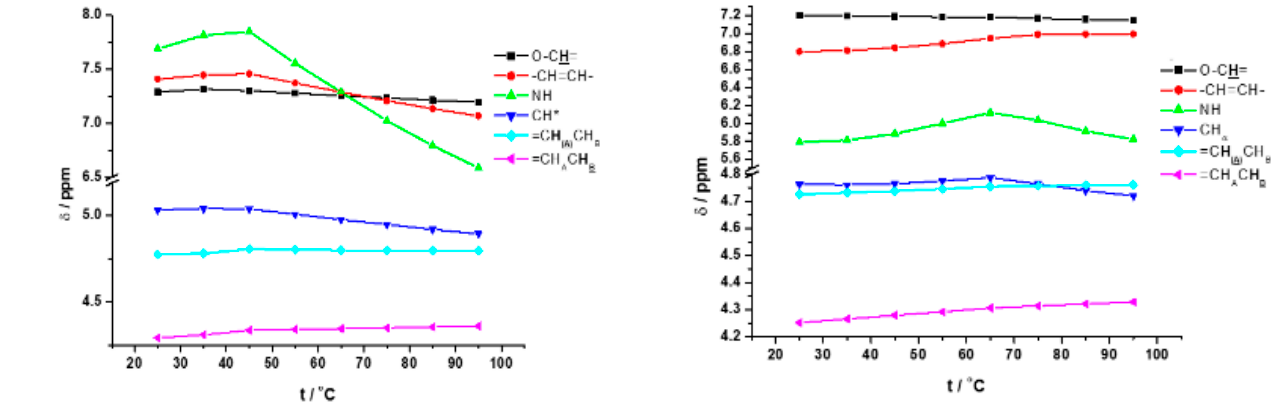
Figure 3. Chemical shifts of 1 a ( left ) and ( b ) 2a ( right ) protons in toluene-d 8 gels in the temperature range of 25–95 °C.